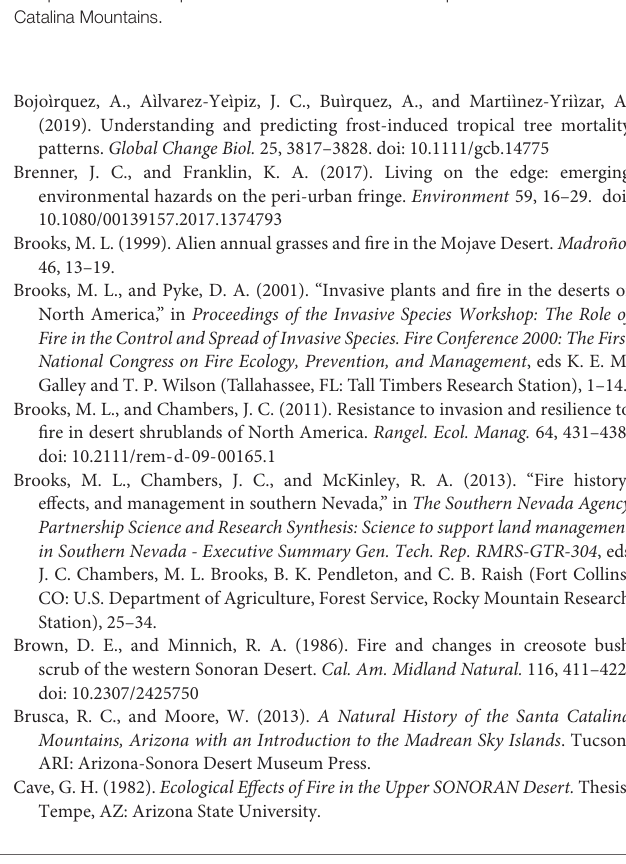
Supplementary Figure 2 | Comparison of digitization efforts based on Google Earth imagery (2018) and helicopter survey (2016) in the Santa Catalina Mountains, east of Sabino Canyon Recreation Area. Previous aerial survey boundaries shown in black have large, circular boundaries, both overestimating patch sizes and underestimating buffelgrass distribution. (A) Map showing numerous helicopter-surveyed patches in comparison to the Google Earth survey. (B) Map showing a single helicopter patch in comparison to the more numerous and complex boundaries of hand-digitized polygons from Google Earth. (C) A single patch identified from Google Earth imagery that was not mapped in the 2016 survey. Supplementary Figure 3 | State-and-transition fire-spread model diagram. (A) State classes defined for the simulation, where uninvaded and seedbank are replicated for each fuel model class. (B) How growth transitions occur deterministically based on amount of time in the state class interacting with a “wet year” (probability of 26.7%) increase in age to decrease the overall amount of time required to transition to the next cover level. Supplementary Figure 4 | State-and-transition fire-spread model study area including the fuel models used in the simulation and the 1,200 masl contour used to explore changes in low elevation fires caused by buffelgrass presence. Supplementary Figure 5 | Locations of sampling plots established to assess saguaro mortality after the 2019 Mercer Fire. Ten plots were established within the zone of fire impact outlined in red. Five control plots were established outside of the fire zone. Circle size indicates the abundance of saguaros within each 20 × 20 m square plot. Grayscale indicates the degree of saguaro mortality in each plot. Supplementary Table 1 | LANDFIRE mapped fuel loadings used in the simulation. Supplementary Table 2 | FARSITE parameter values used in all simulations within SyncroSim. Supplementary Table 3 | Patch sizes of the 10 largest buffelgrass patches compared to all other patches combined on the south slope of the Santa Catalina